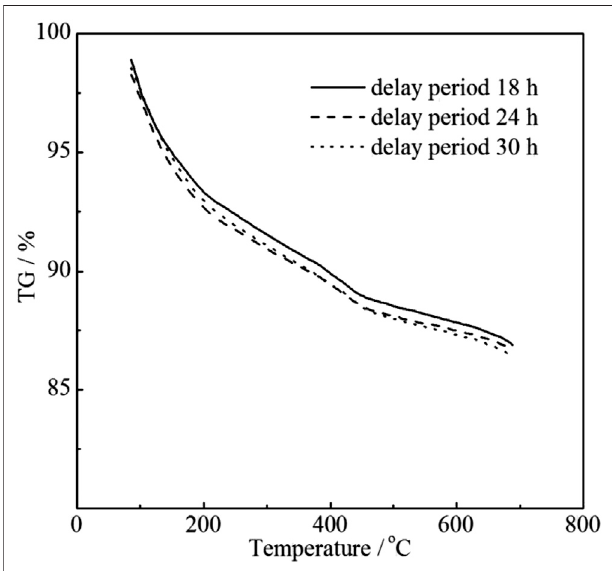
Figure 13 | DSC curves of the paste under different delay